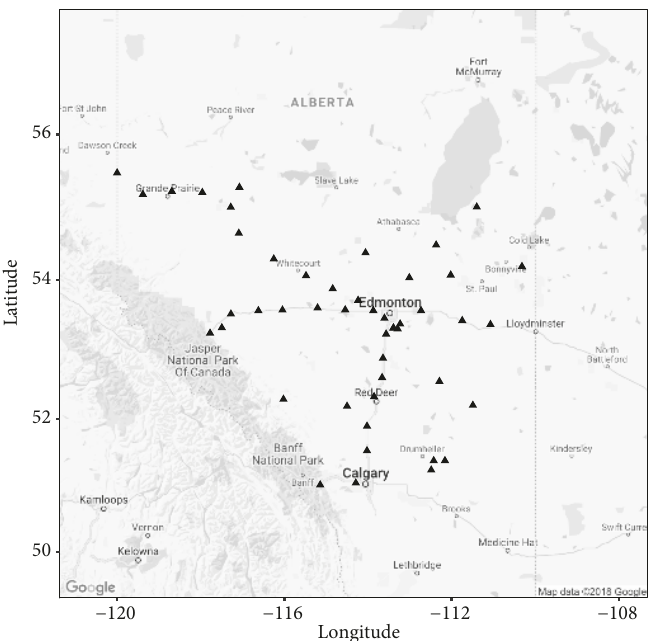
Figure 3: Data source: stationary RWIS